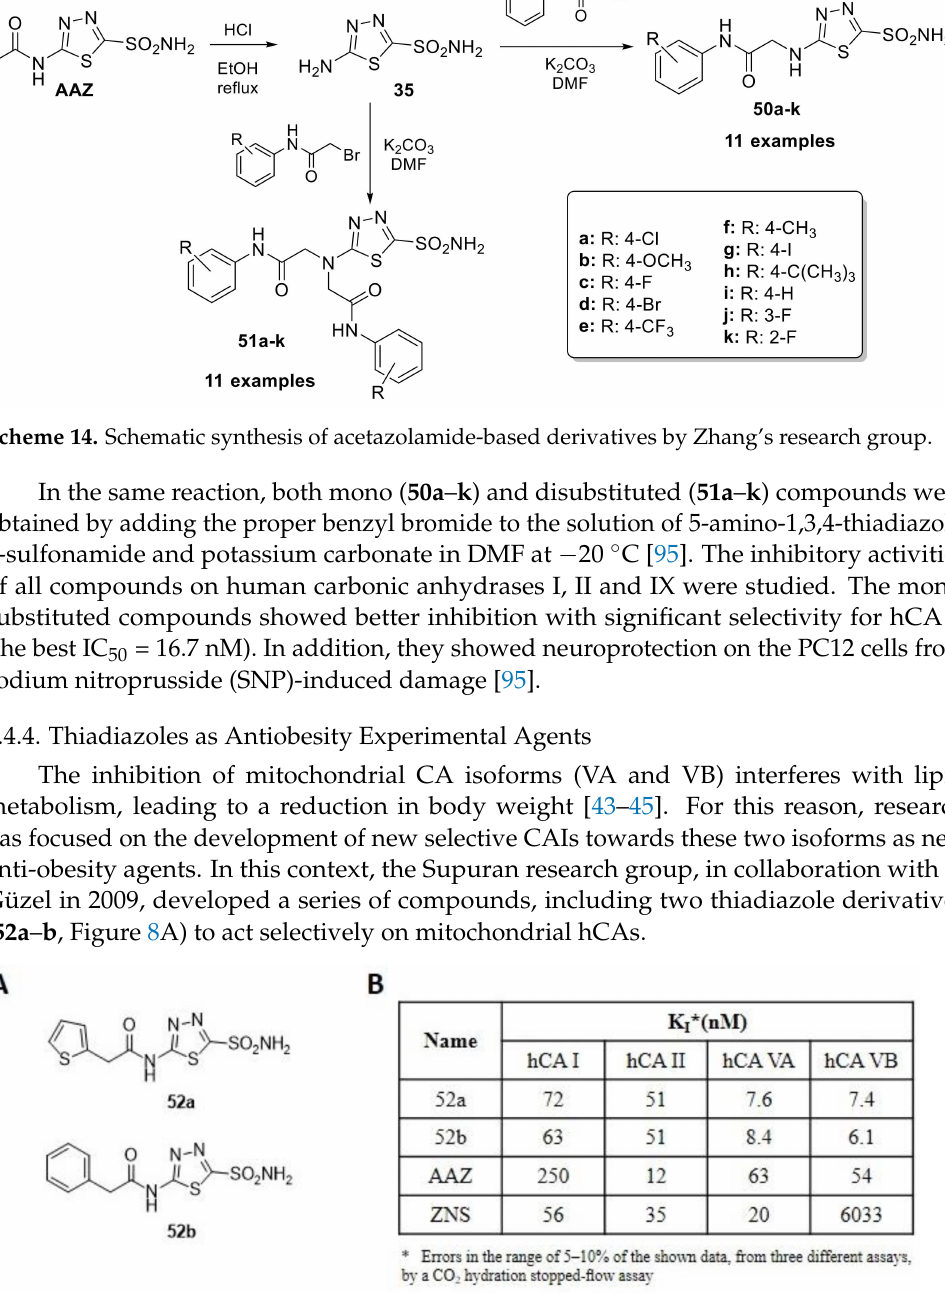
Figure 8. ( A ) Structure of thiadiazole derivatives 52a – b synthesized by Supuran and Güzel research groups. ( B ) Inhibition data of human CA isozymes I, II (cytosolic), VA and VB (mitochondrial) with compounds 52a – b and standard inhibitors ( AAZ and ZNS